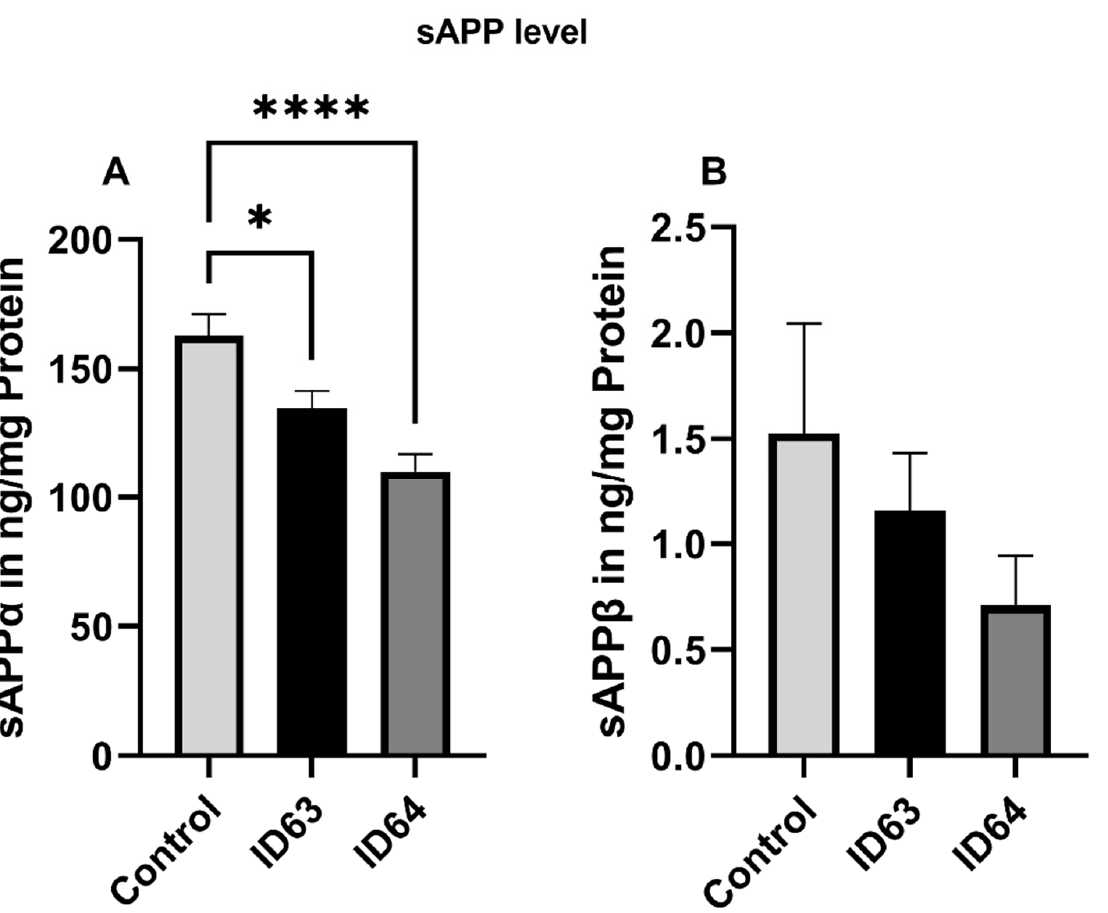
Figure 3. Effect of the incubation with ID63 or ID64 on the human soluble amyloid precursor protein α (sAPP α ) and β (sAPP β ) after 24 h of incubation. ( A ) sAPP α level of SH-SY5Y 695 cells after the